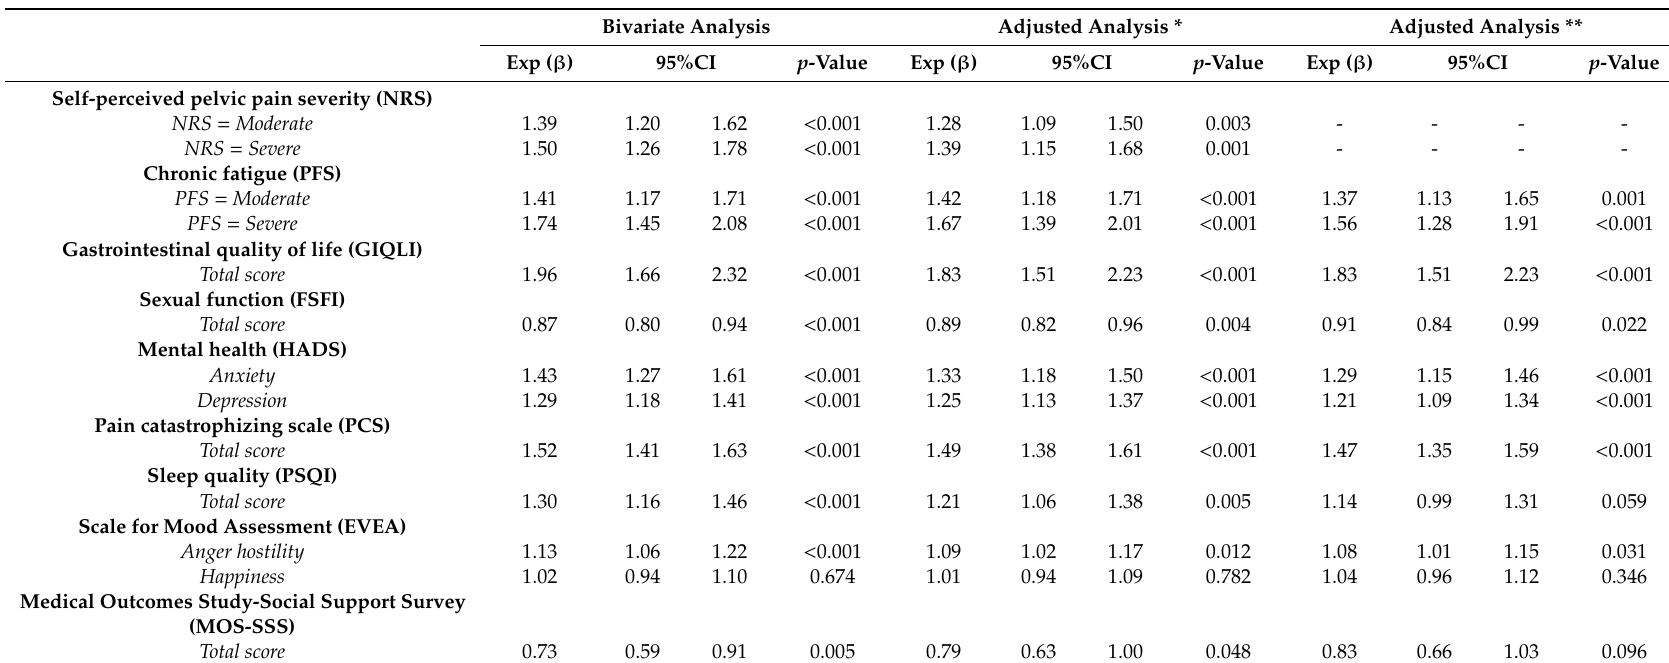
Table 4. Relationship between psychosocial impairments and quality of life in women with endometriosis. Linear regression analyses. Bivariate Analysis Adjusted Analysis * Adjusted Analysis